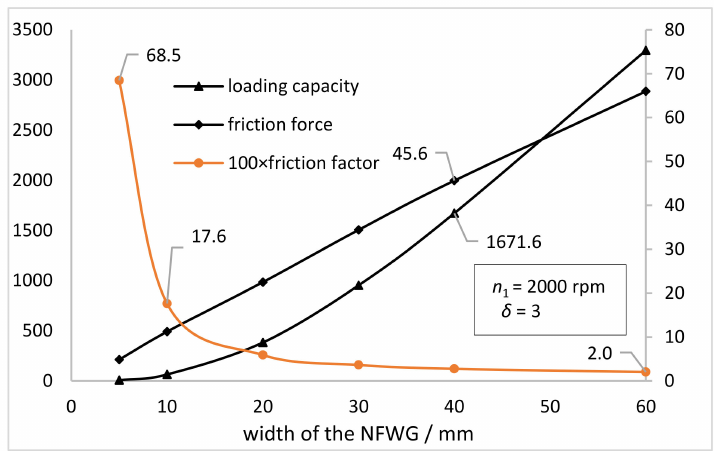
Figure 10. Variations of the loading capacity and friction force and friction factor on the inner wall of the FS with the width of the NFWG ( n 1 = 2000 rpm, δ =